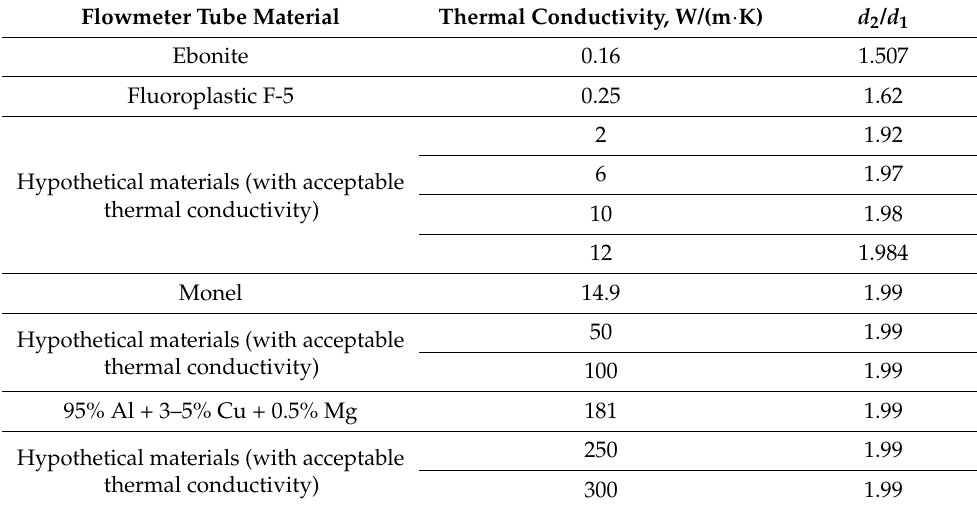
Table 2. Selection of geometric parameters and material of the thermal flowmeter tube.